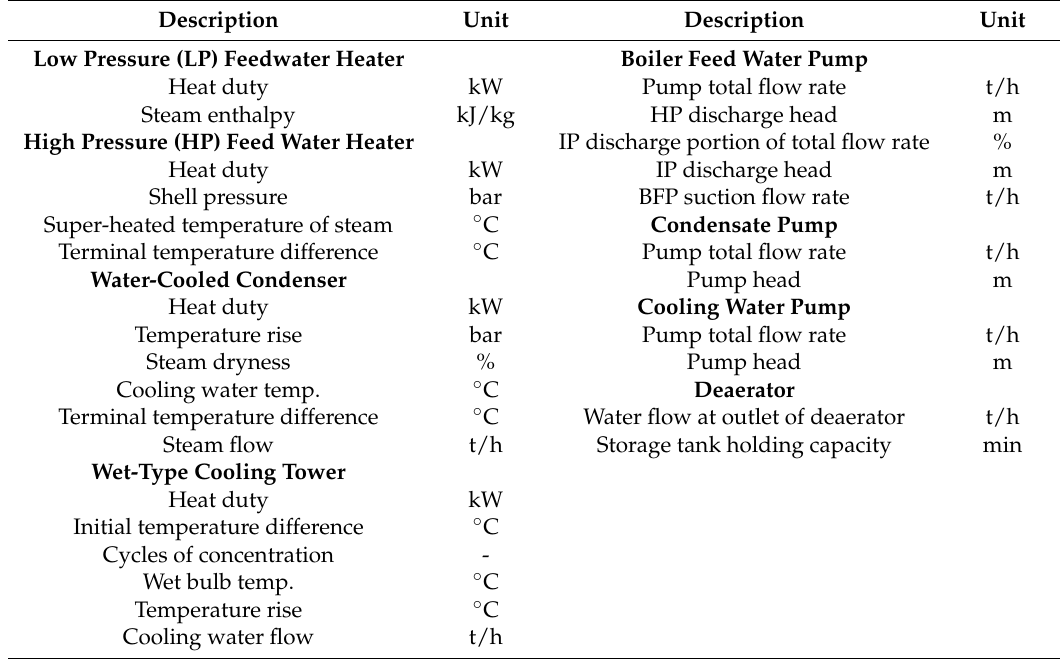
Table 3. Selected main design value affecting cost by